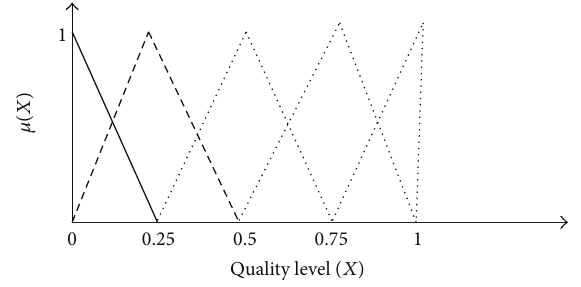
Figure 2: Membership functions for 5 linguistic terms.